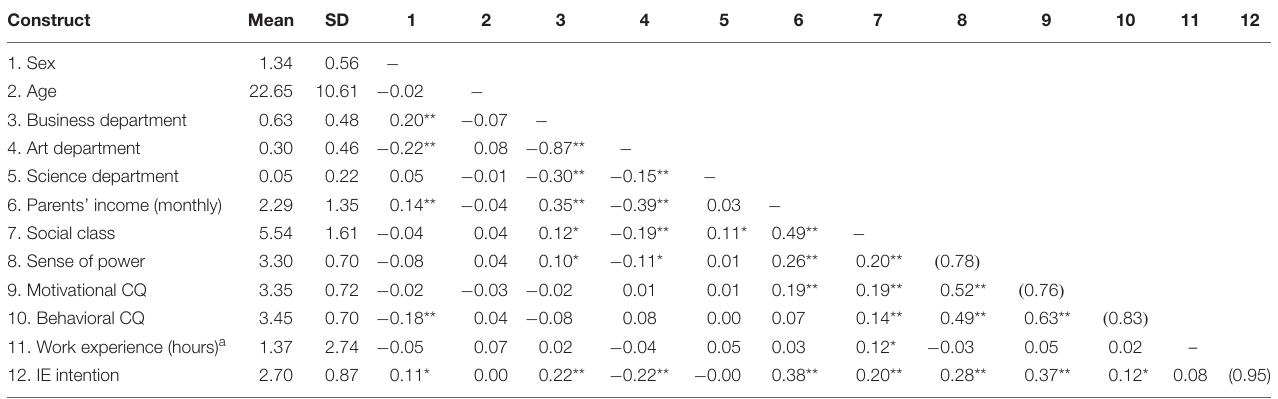
TABLE 2 | Correlations and discriminant validity. Construct